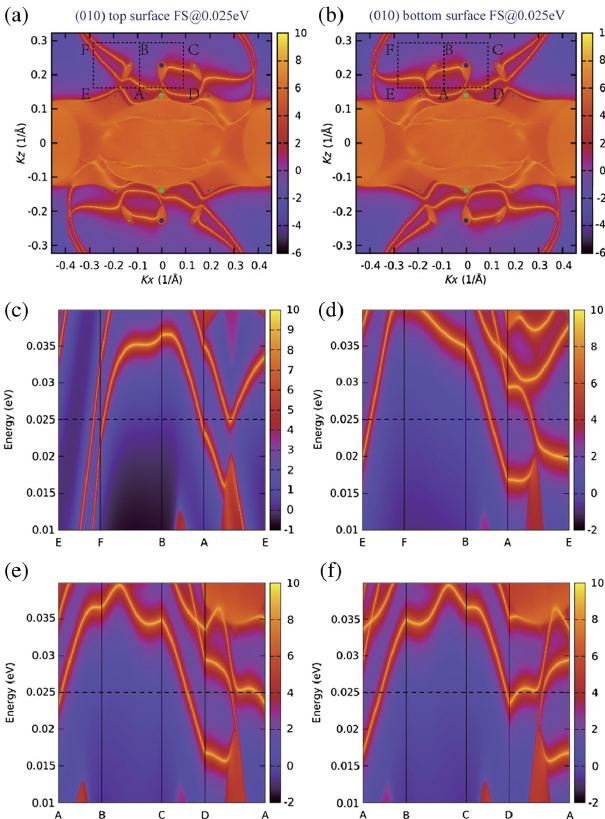
FIG. 8. Fermi surface of the second cleaved cell and the identification of the chirality of the surface state. (a,b) Fermi surface on top and bottom (010) surfaces, respectively. The small dots represent the single projected WP, and the large dots represent two WPs with the same chirality projecting on top of each other. Panels (c) and (e) are the surface states of the top surface along the closed paths of E-F-B-A-E and A-B-C-D-A, respectively. Panels (d) and (f) are the same as (c) and (e) but for the bottom